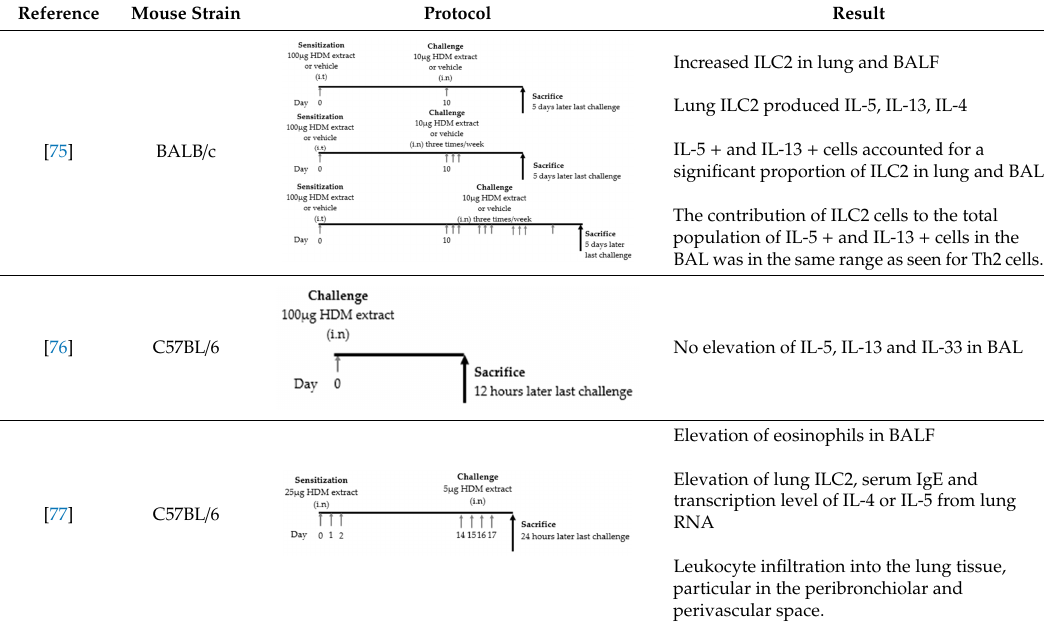
Table 1. Experimental protocols of house dust mite-induced murine asthma models. Reference Mouse